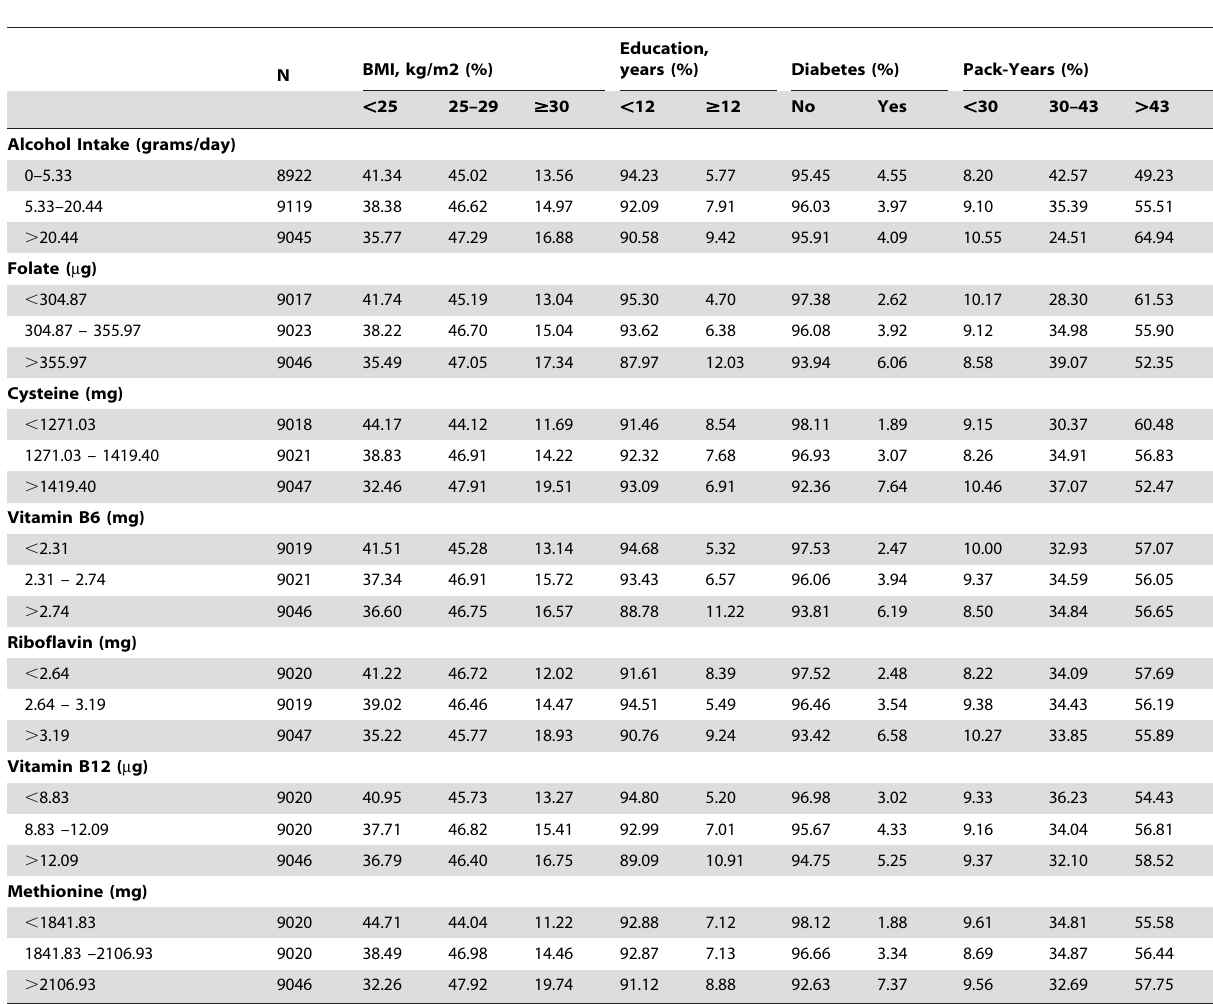
Table 1. Distribution of select baseline characteristics across total one-carbon metabolite intake tertiles and alcohol consumption in the ATBC